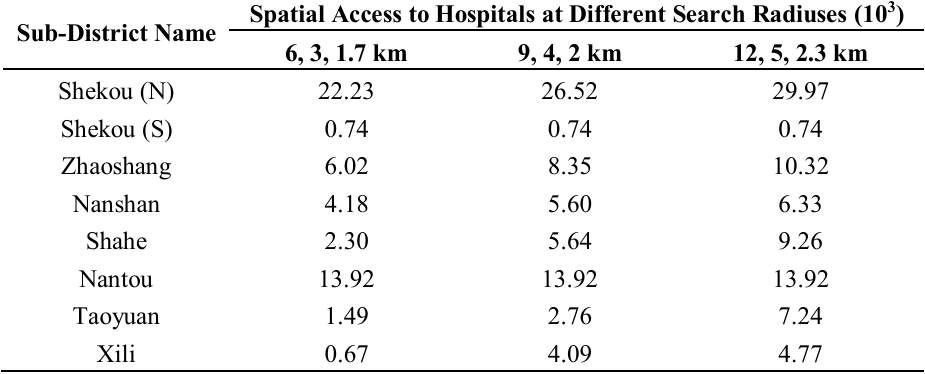
Table 5. Spatial access to hospitals in each sub-district within different search